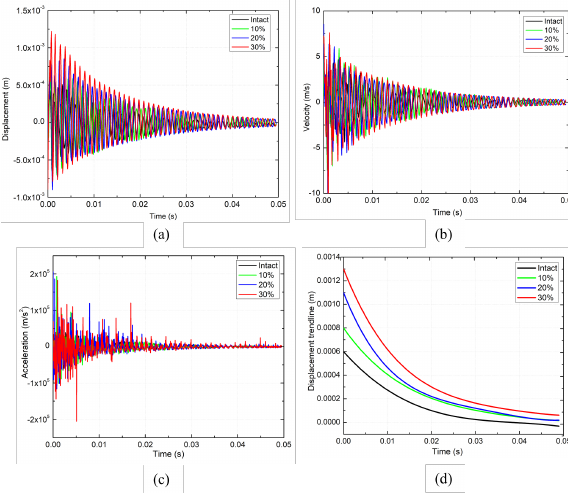
Figure 18: Comparison of transient response between intact and debonded models a) displacement b) velocity c) acceleration d) displacement trendline.